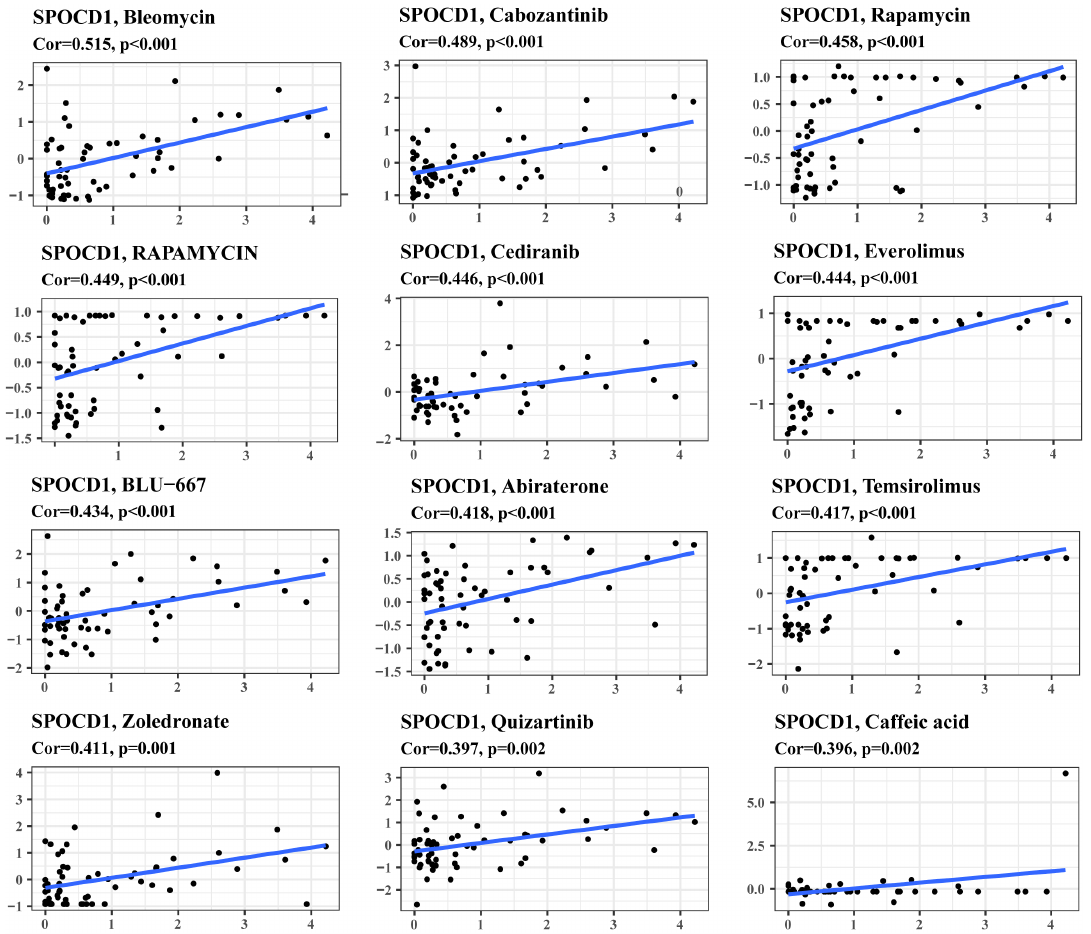
Figure 8. Gene-drug sensitivity analysis based on the CellMiner database: the top 12 drugs with high correlation with SPOCD1 expression in CRC were screened.